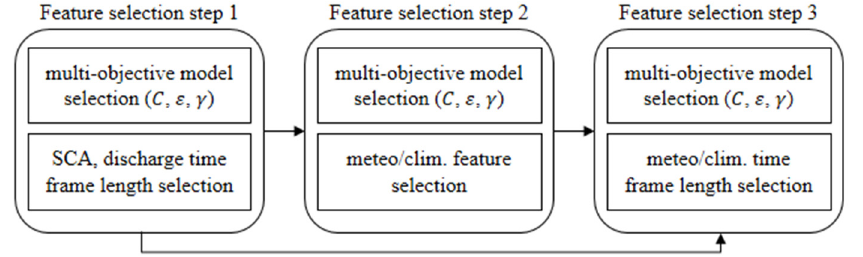
Figure 4. Feature selection scheme. The first step is relative to the selection of the time series length of the catchment state variables SCA and discharge. The second and the third step deal with the selection of the climatic and meteorological parameters that describe precipitation and